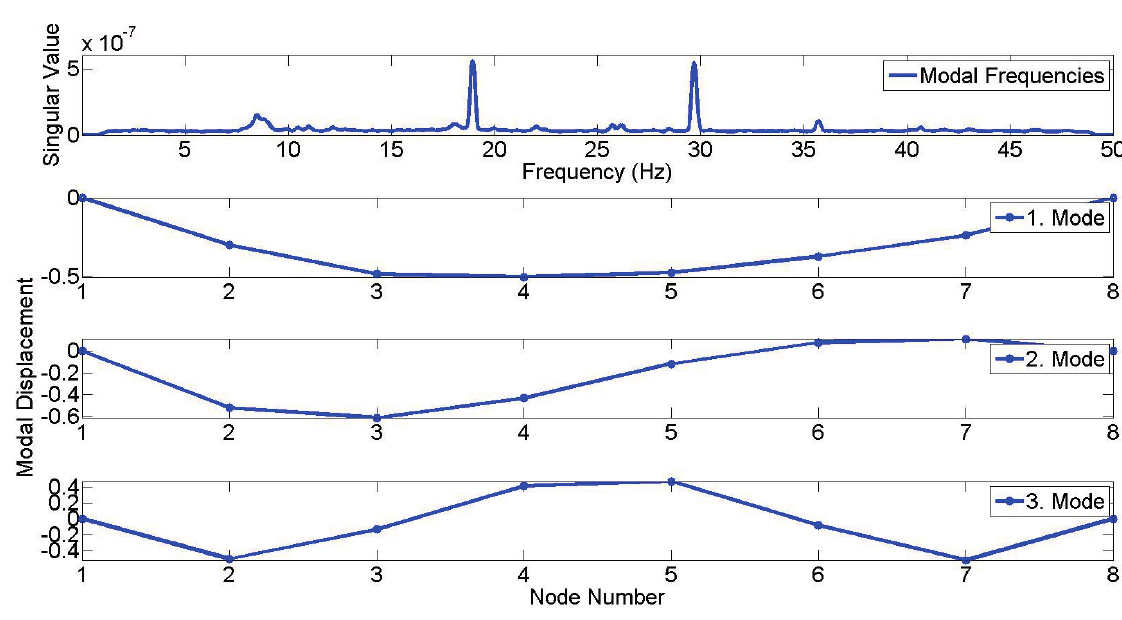
Figure 6. 1st, 2nd, and 3rd modal frequencies (8.46, 18.95, 29.67 Hz) and mode shapes from FDD by reference